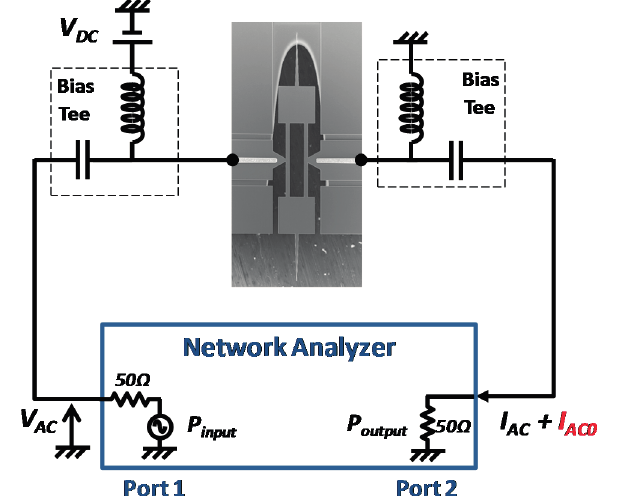
Figure 5. Schematic representation of working principle. V DC is used to bias the actuator beams for piezoresistive detection. Network analyzer generates a driving signal V AC and collects the output piezoresistive current I AC .